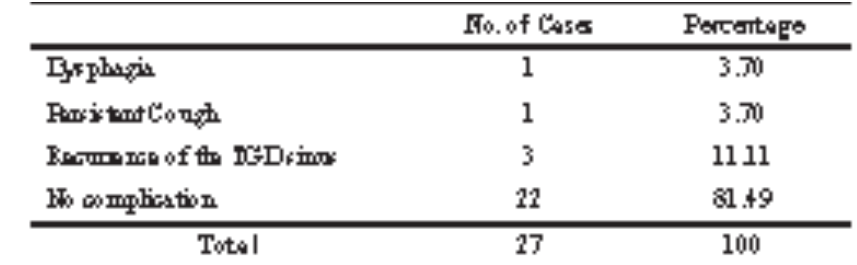
Table II: Post-operative